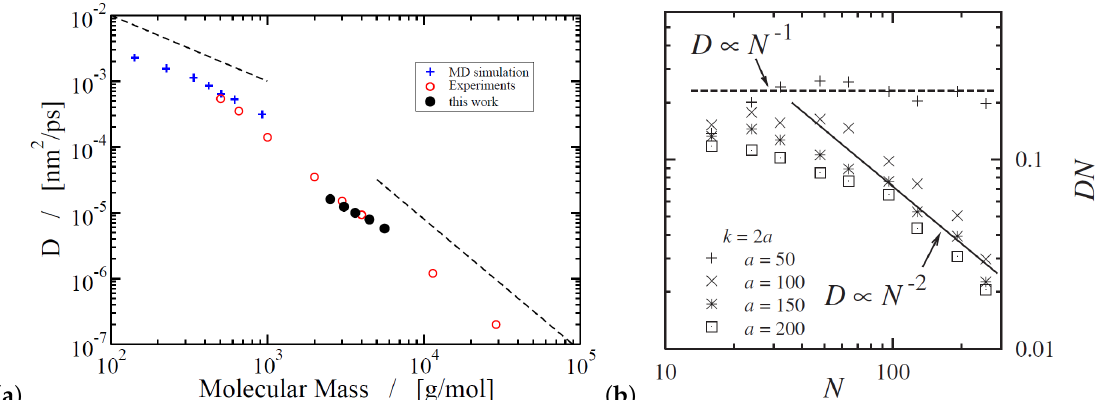
Figure 11. ( a ) Self-diffusion coefficients of linear polymers as a function of molecular mass. The black dots are the results of Fan and Liu [165], the filled circles represent experimental data from Pearson et al. [52], and the plus symbols show molecular dynamics simulation results obtained by Mondello and Grest [166]. The dashed lines illustrate the slopes expected for the Rouse regime (left, D ∼ M − 1 ) and the reptation regime (right, D ∼ M − 2 ). Reprinted from [165] with permission from IOPscience. ( b ) Proper scaling limits are reached for the diffusion coefficient D , by DPD simulations ( α is the force bond constant). Reprinted from [167] with permission from the American Physical Society